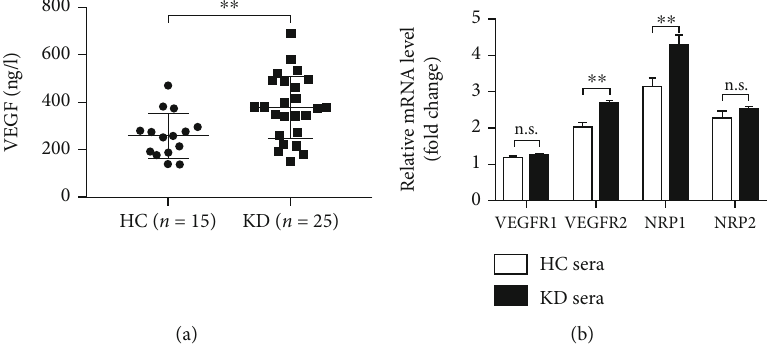
Figure 2: VEGF is increased in the KD group, and KD sera promote VEGFR2 and NRP1 expression of HCAECs. (a) Levels of VEGF in the HC group and the KD group. (b) E ff ect of human sera on mRNA levels of VEGFRs and NRPs in HCAECs. HCAECs were treated by medium containing 20% sera from healthy children (HC sera; pooled from 10 individuals) or from KD patients (KD sera; pooled from 10 patients). The mRNA level of each gene was normalized to that of β -actin. Data are expressed as M ± SD from 3 separate experiments. ∗∗ P < 0 : 01 ; n.s.: not signi fi cant.